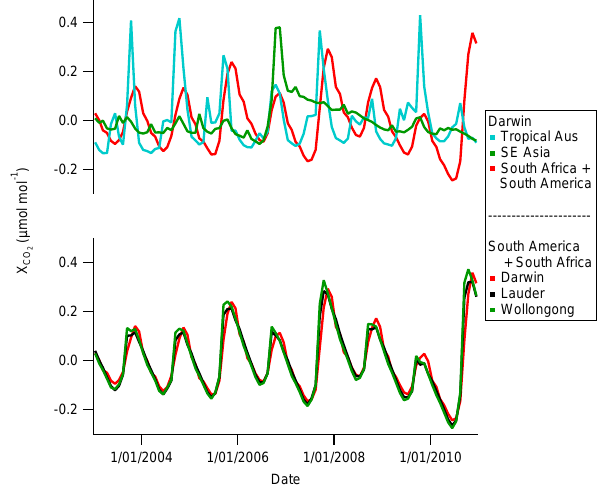
Figure 8. Time series of regional decomposition of the detrended time series for the South American and South African biomass burning tracer at all three sites and the tropical Australian and Southeast Asian tracers as sampled at